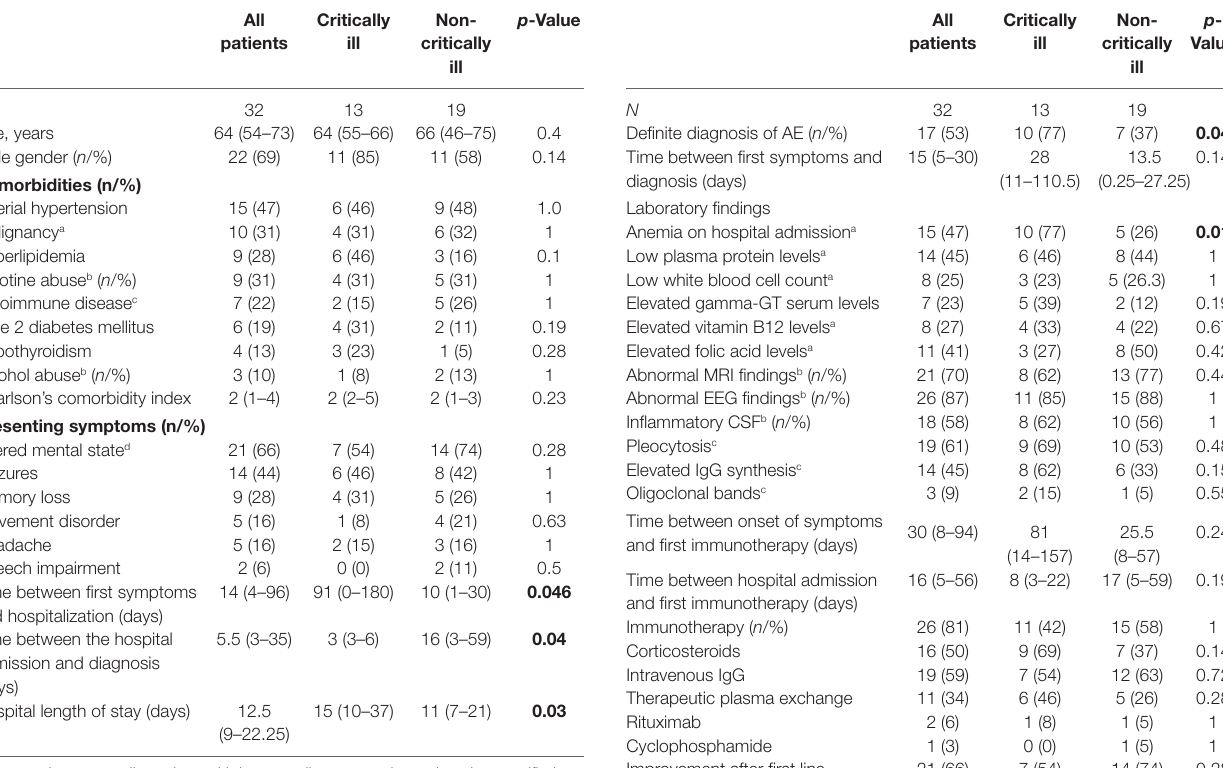
TaBle 2 | Diagnostic findings and therapies of 32 patients with autoimmune encephalitis.